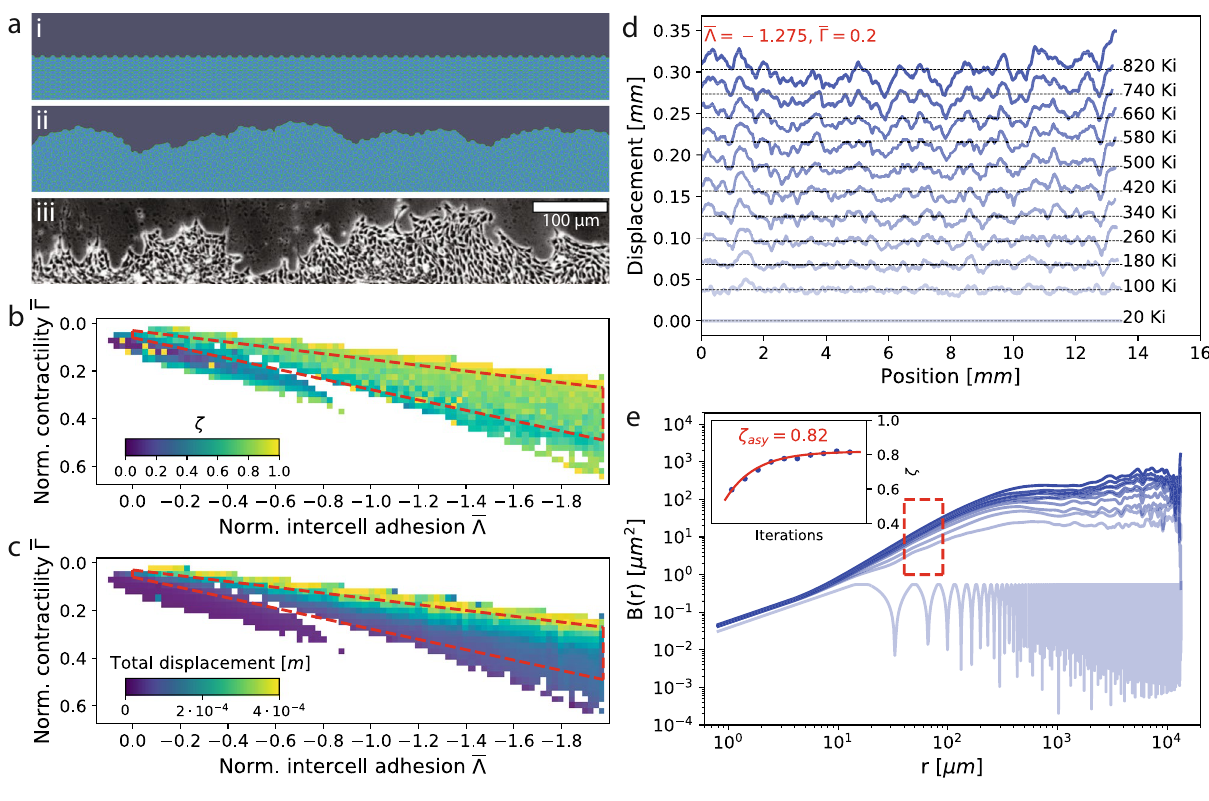
Figure 4. Numerical simulations of propagating cell fronts. ( a ) Initially flat fronts of regular two-dimensional hexagonal cells (i) were allowed to evolve under energy balance conditions 24 to a steady state rough configuration (ii), visually comparable to the Rat1 fibroblast cell fronts imaged by phase contrast (iii). Phase diagram of the ( b ) roughness exponent ζ and ( c ) total displacement of the cell front simulations as a function of the normalized intercell adhesion (cid:31) and normalized cell contractility Ŵ . The lower branch corresponds to pathological scenarios in which little cell division occurs, accompanied by negligible front motion and roughening. The upper branch corresponds to non-pathological scenarios in which the colony grows and the front proliferates to reach an apparent steady state rough configuration and linear velocity. White space corresponds to unsuccessful simulations (see SI 10). The dashed red-coloured bounding box identifies the main region of stability and physical behaviour. ( d ) Evolution of a full ≈ 14 mm simulated cell front for � = − 1.275, Ŵ = 0.2 typical of the upper non-pathological branch, progressively roughening as a function of iterations from the initial flat configuration. Selected fronts are shown at intervals of 80000 iterations (80 Ki), demonstrating a linear velocity of the interface. ( e ) Average roughness B ( r ) = (cid:31) | � u ( r , z ) | 2 (cid:30) ∼ r 2 ζ of the fronts in ( d ), evolving from a periodic function reflecting the initial configuration to a steady state presenting a single region of power law scaling. The evolution of the roughness exponent ζ , extracted by fitting the region indicated by the red box, is shown in the